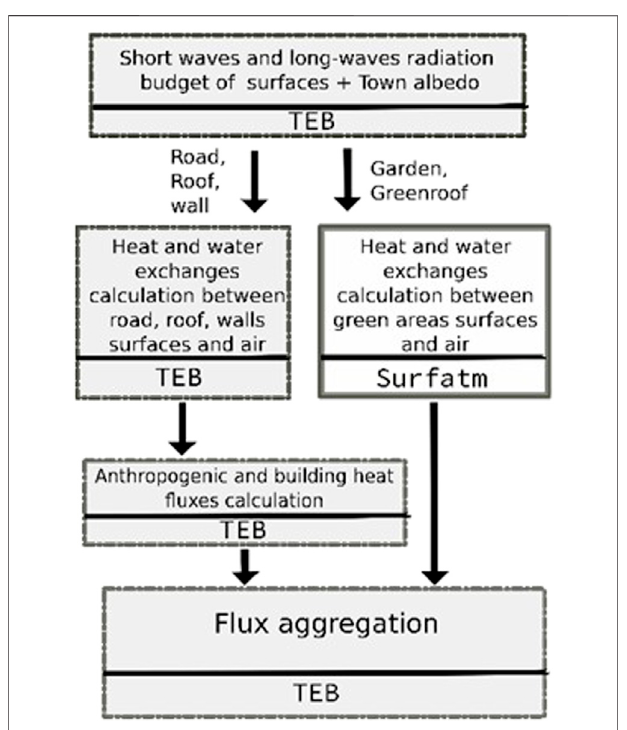
FIGURE 1 | Diagram of inclusion of the Surfatm model into the TEB model.